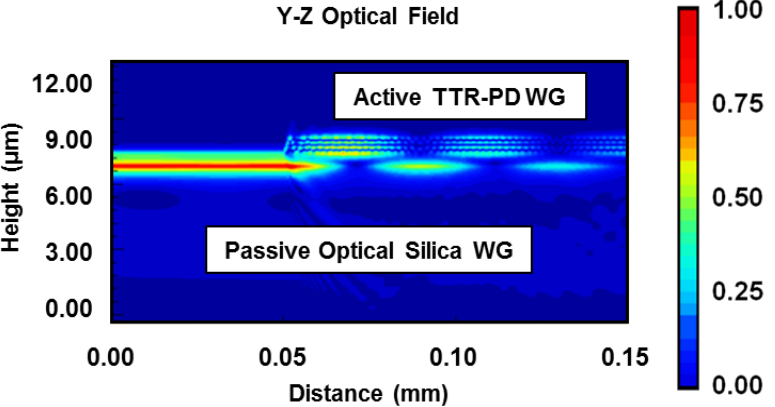
Figure 3. Simulated propagation of TE-polarized light demonstrating evanescent coupling between a silica waveguide (WG) and the InP-based TTR-PD WG (longitudinal